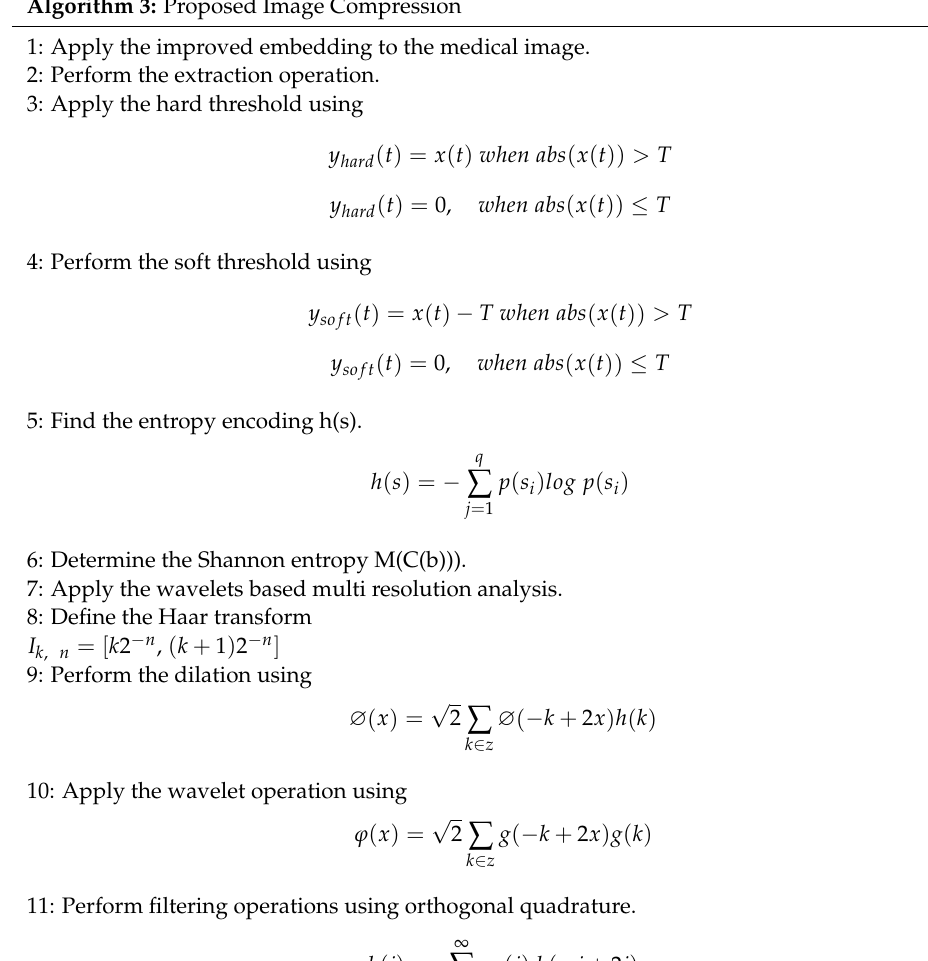
Algorithm 3: Proposed Image